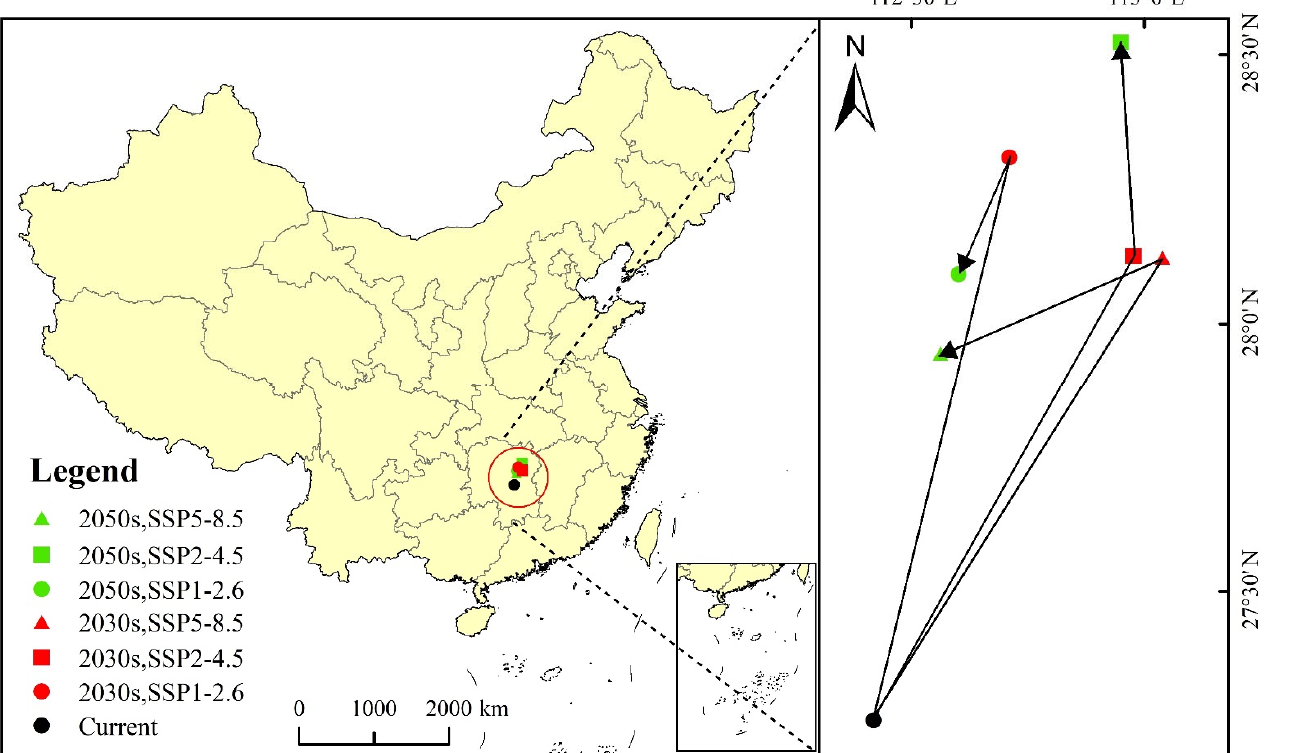
Figure 9. Distribution centroids of Linepithema humile under current and future climatic scenarios in China.